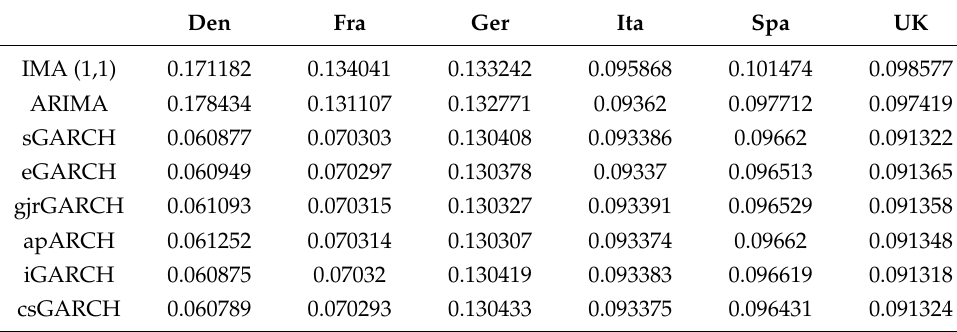
Table 3. MWE for original observations of 2019, without removing